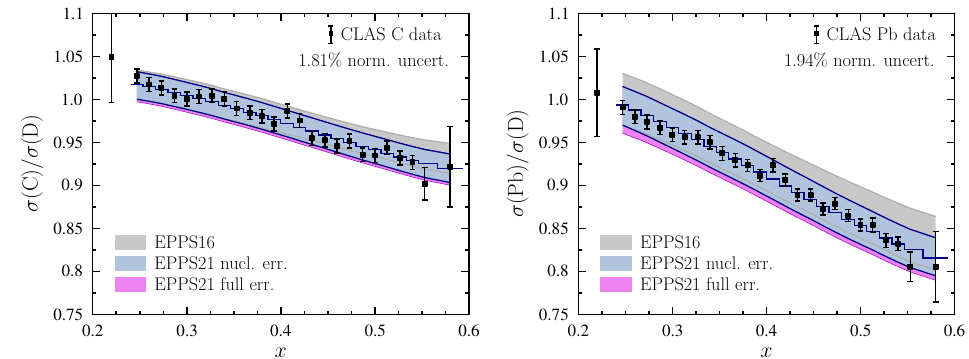
Figure 3: A sample of the new JLab CLAS Collaboration data [ 7 ] included in the EPPS21 analysis: The carbon-to-deuteron (left) and lead-to-deuteron (right)